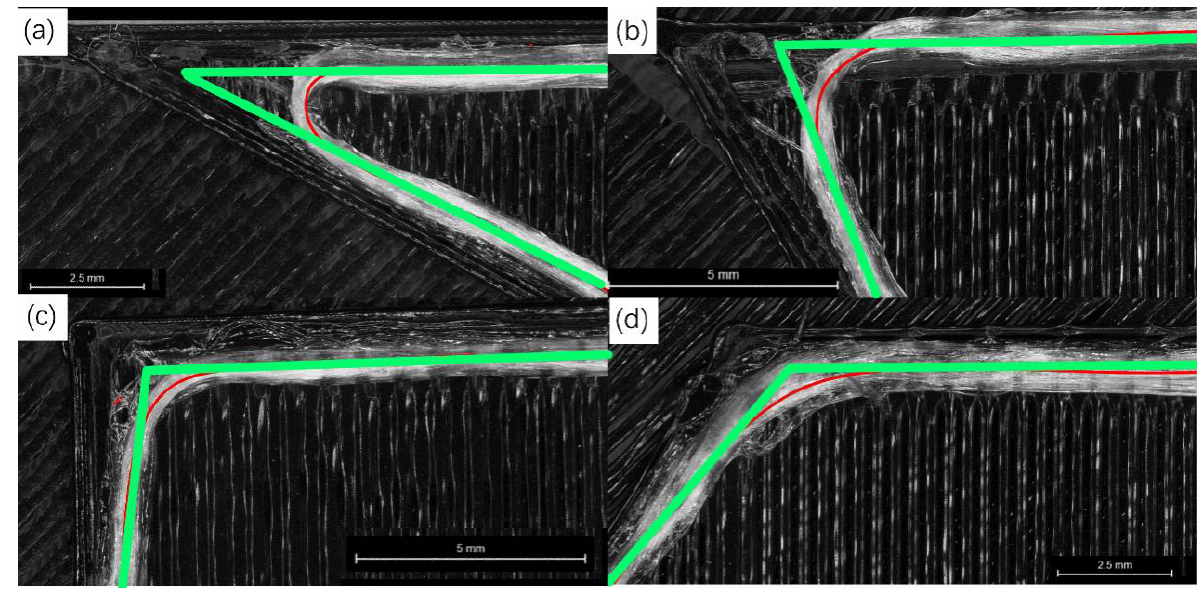
Figure 4. Printing with different corner angles, ( a ) 30°, ( b ) 60°, ( c ) 90°, ( d ) 120°. White: CGFRF/PLA. Black: PLA. Red: extracted CGFRF trace lines. Green: ideal tracks.